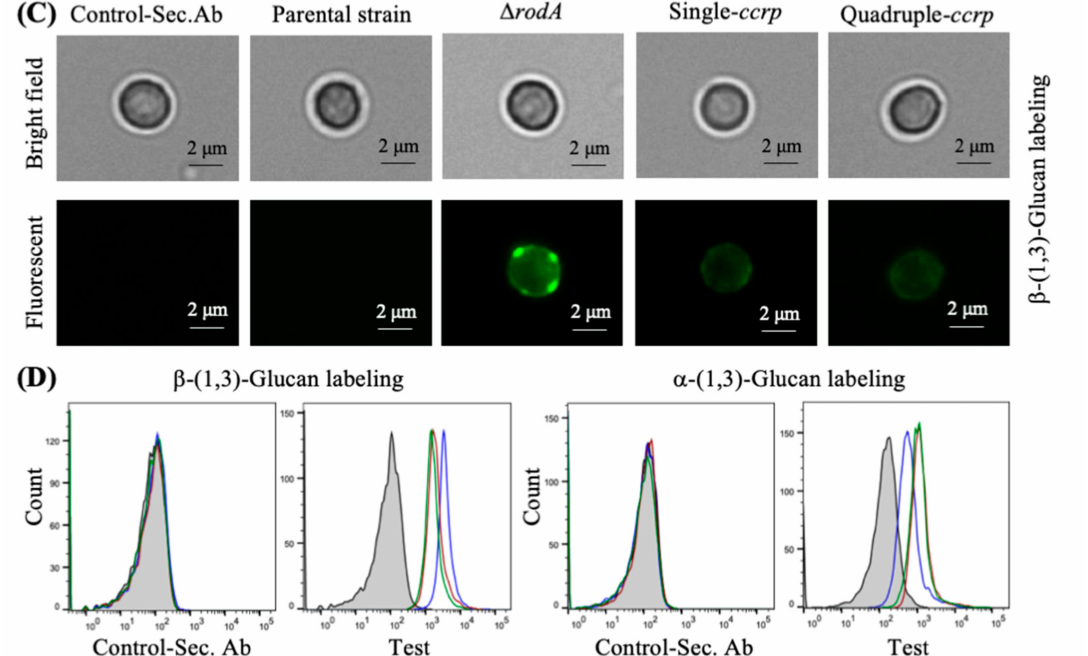
Figure 3. Immunolabeling of parental strain, ∆ rodA and ccrp-mutant dormant conidia with MelLec, Dectin-1 (both human Fc-conjugated), and polyclonal anti- α -(1,3)-glucan-serum (melanin ( A ), α -(1,3)-glucan ( B ) and β -(1,3)-glucan ( C ), respectively); the controls were conidia treated with secondary antibodies (Fc-specific anti-human-IgG-FITC for MelLec and Dectin-1, and anti-mouse-IgG-TRITC for α -(1,3)-glucan). Parental strain conidia showed punctate labeling for MelLec and were negative for β -(1,3)- / α -(1,3)-glucan, ∆ rodA conidia showed uniform labeling for MelLec, intense labeling for β -(1,3)-glucan and weak labeling for α -(1,3)-glucan; while both single and quadruple ccrp -mutants showed strong labeling for α -(1,3)-glucan but weak β -(1,3)-glucan labeling. ( D ) Flow cytometry upon labeling conidia for β -(1,3)-glucan and α -(1,3)-glucan (two biological replicates; in gray-filled—parental strain, in blue line— ∆ rodA , single-ccrp — in red line and quadruple-ccrp—in green line; controls were conidia treated with only FITC-conjugated secondary antibodies) (in the spectra shown, median fluorescence intensities were, for β -(1,3)-glucan—58, 3314, 1685 and 1364, respectively, for parental strain, ∆ rodA , single and quadruple-ccrp mutants, and for α -(1,3)-glucan—135, 544, 1069, and 1017, respectively, for parental strain, ∆ rodA , single and quadruple-ccrp